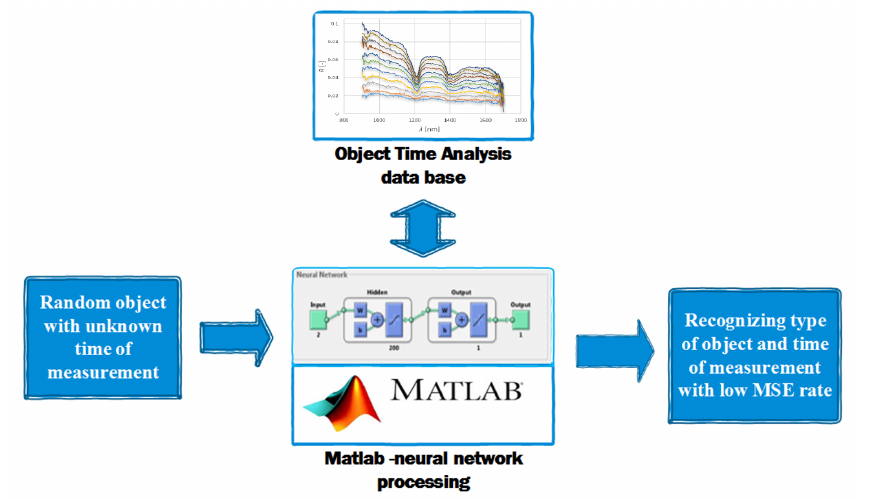
Figure 7. Conception of future development of software in